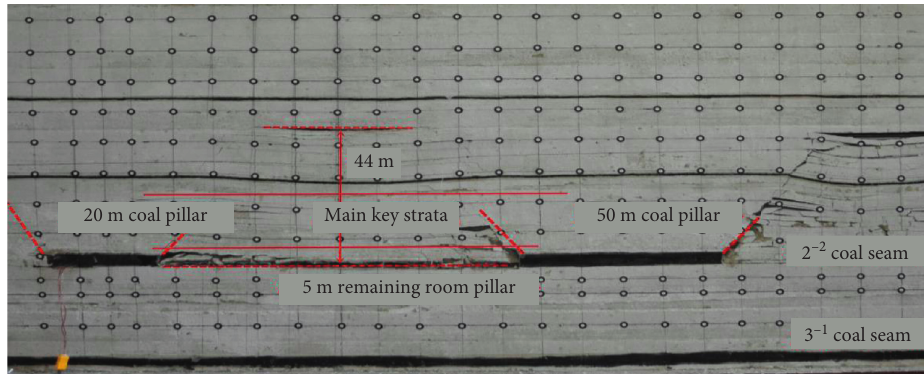
Figure 9: Similarity simulation of the coal pillar in the room gob.